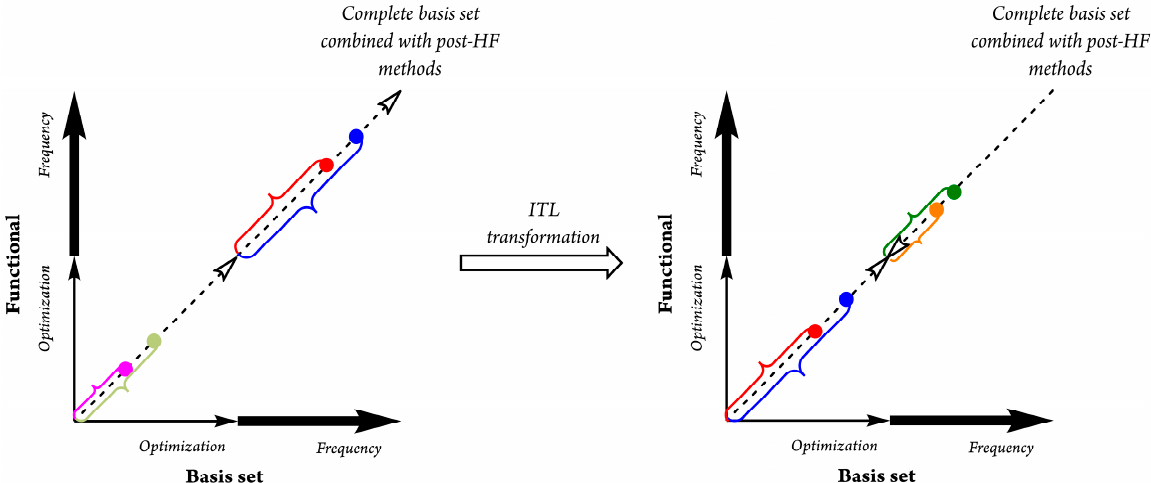
Figure 1. Graphical representation of the difference between the three-step corrected ( left ) and the standard (two-step corrected) approach of the ITL methodology ( right ). The hollowed arrows indicate the degree of theory extension or loss depending on the step (the same notation is used in Figure 2).